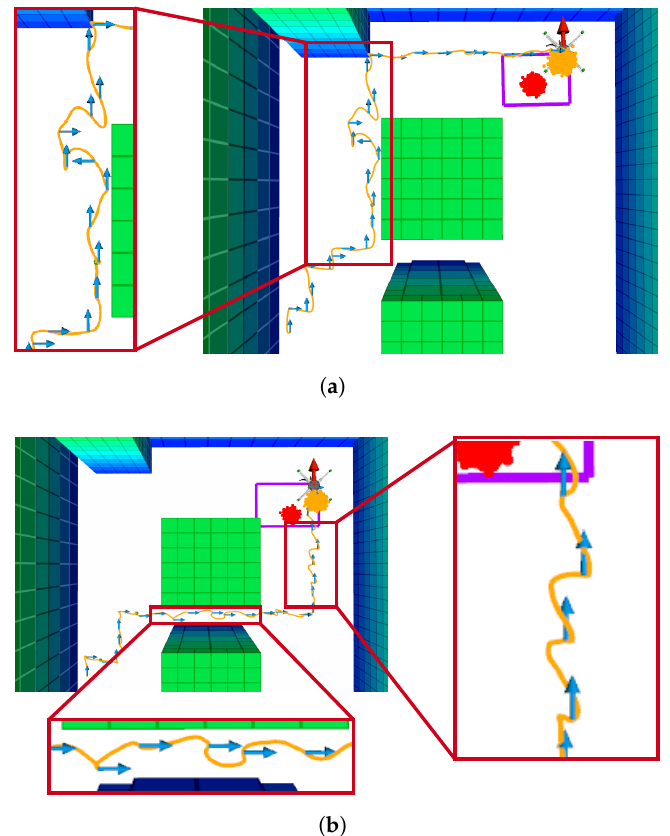
Figure 14. Stability anomalies on the traced UAV trajectory during real flight tests. ( a ) Noisy UAV trajectory in a mission with single belief cluster. ( b ) Noisy UAV trajectory in a mission with dual belief